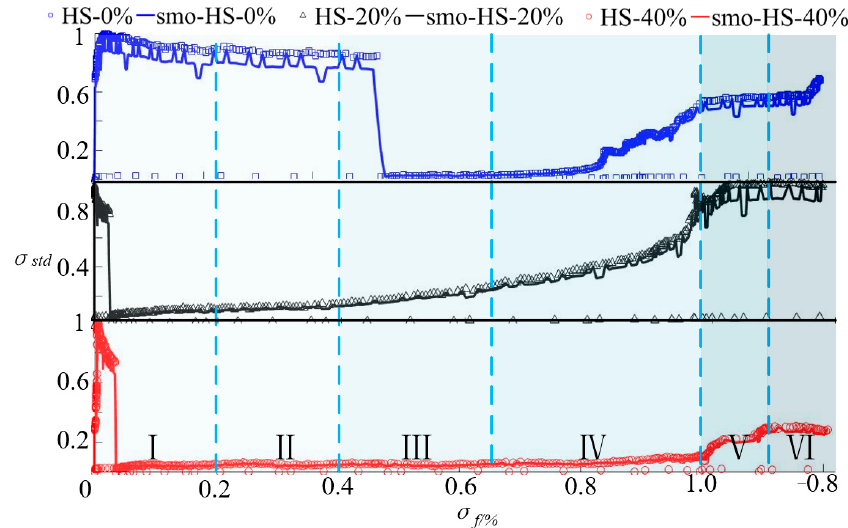
Figure 8. Grayscale standard deviation–stress level curve.